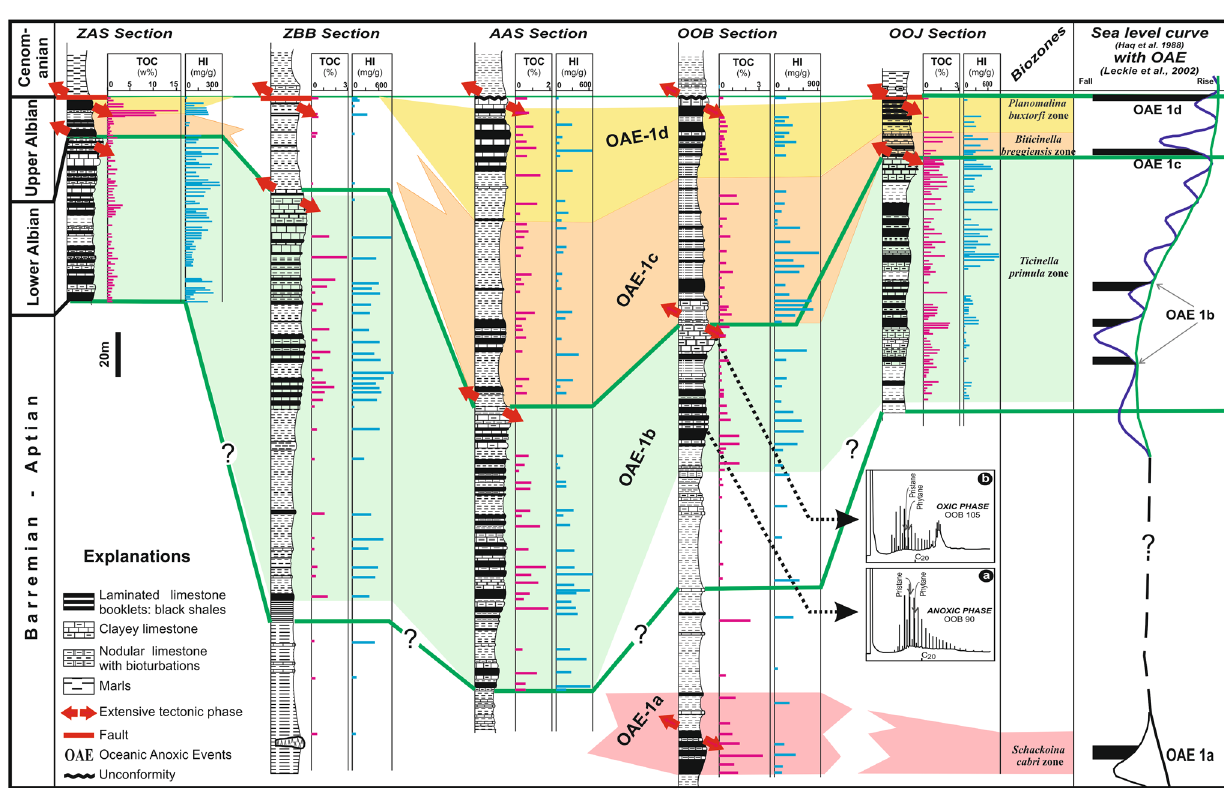
Fig. 6 Anoxic sub-events correlation with the organic geochemical parameters of Bir M’Cherga Aptian–Albian source rocks compared to their Western North Atlantic equivalents (Leckie et al. 2002) and the Vail sea level curve (Corel Draw figure exported into jpeg format)